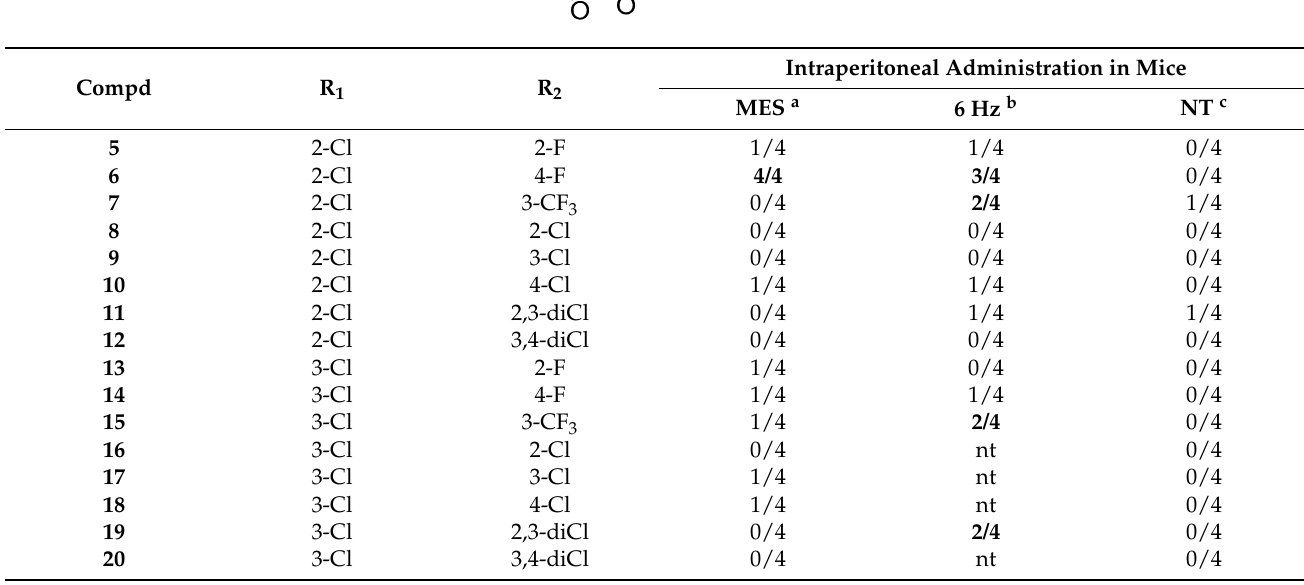
Figure 2. The bioavailability radar of compounds 6 ( left ) and 19 ( right ).